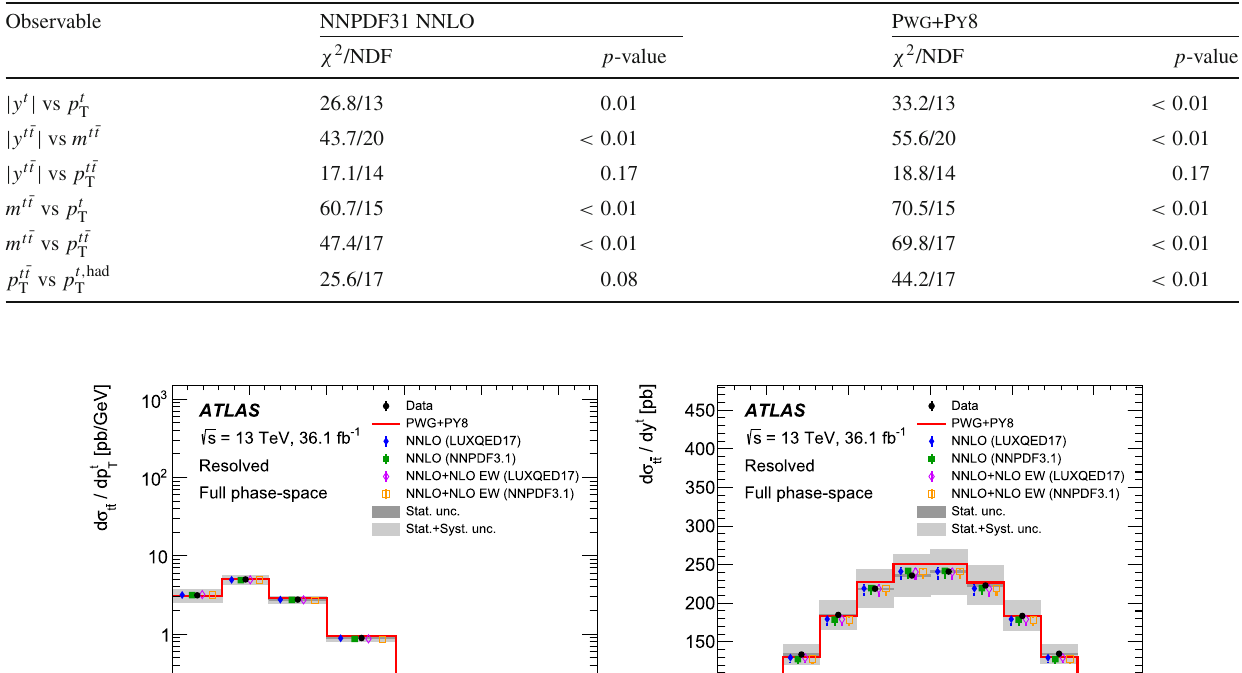
line is the nominal NLO Powheg + Pythia8 prediction. The bands rep- resent the statistical and total uncertainty in the data. Data points are placed at the centre of each bin. The lower panel shows the ratios of the predictions to data. The binning adopted in these distributions is the same used in a recent measurement from the CMS collaboration